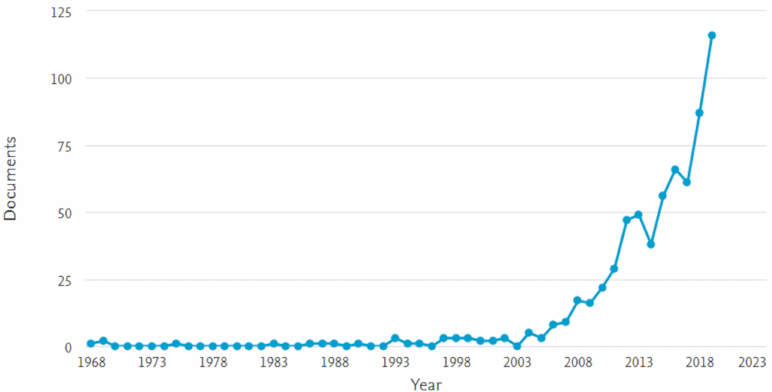
Figure 2. Number of documents in list “A” for each year.